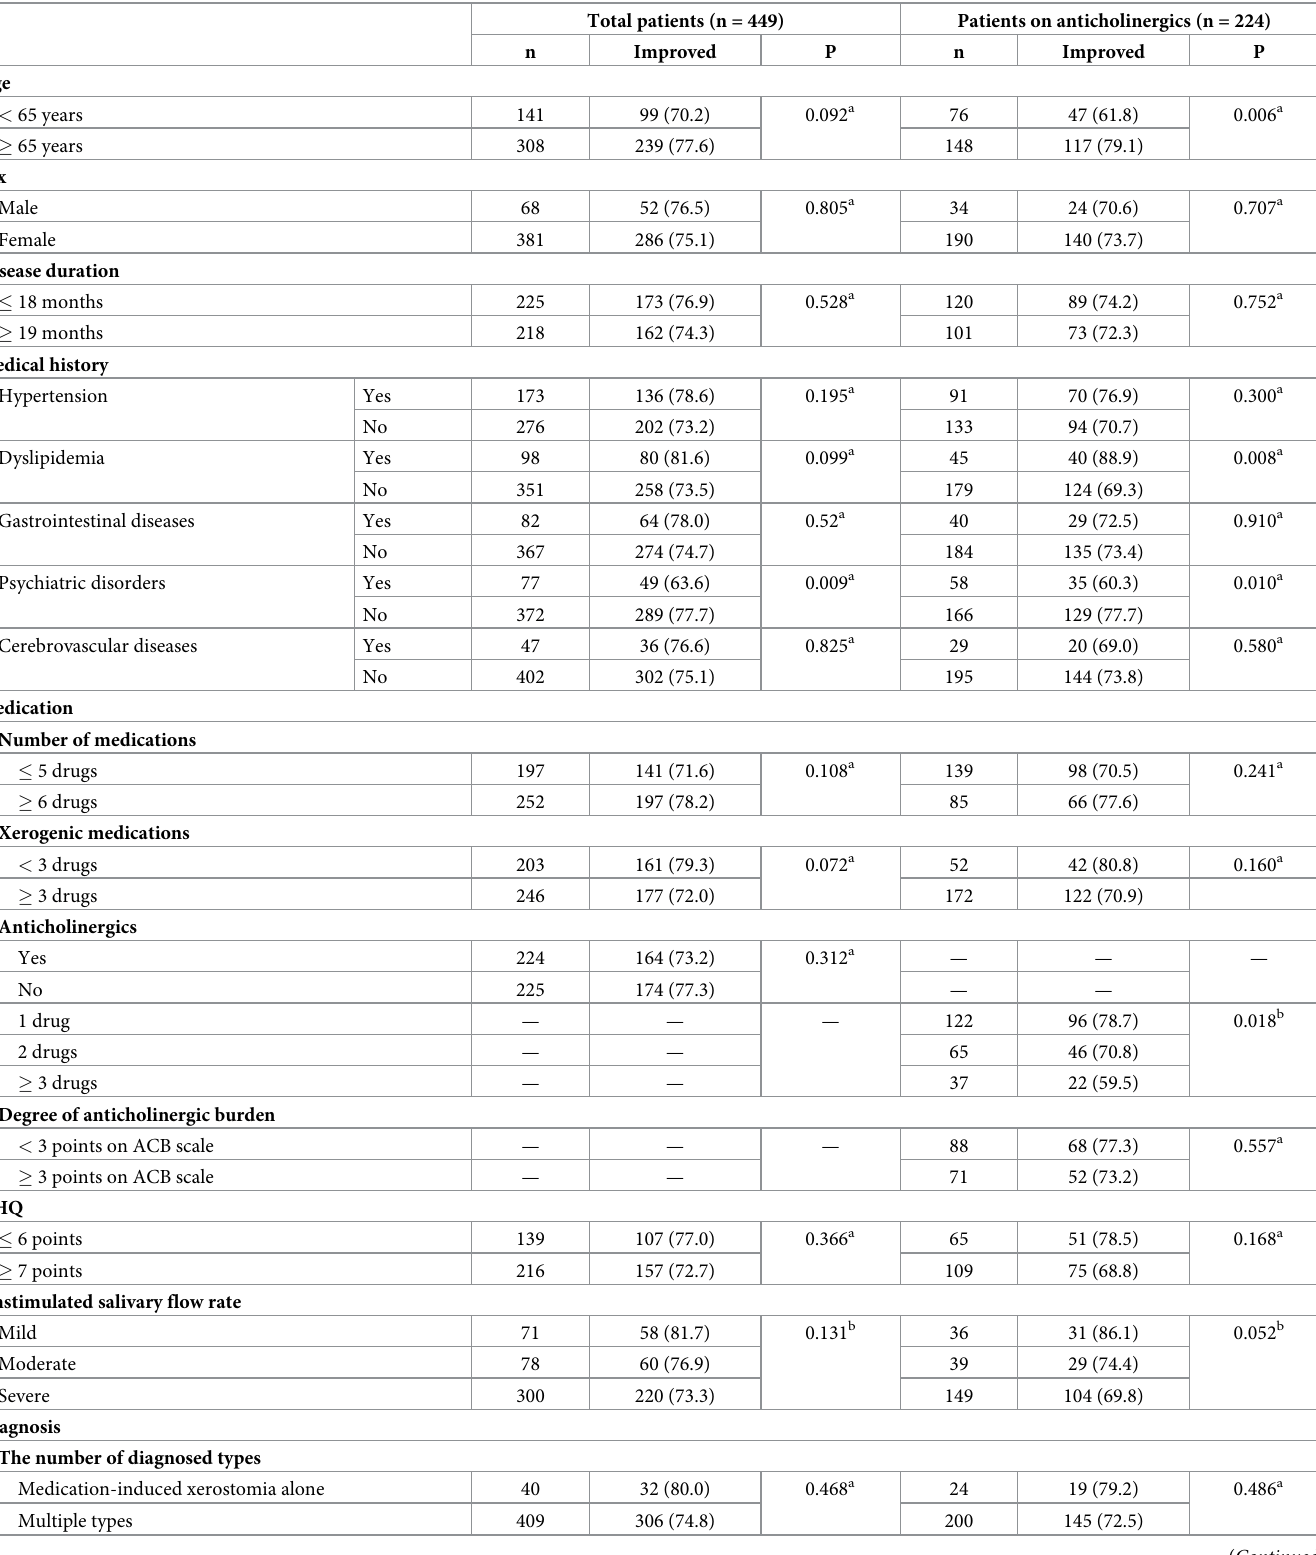
Table 2. Subjective improvement in